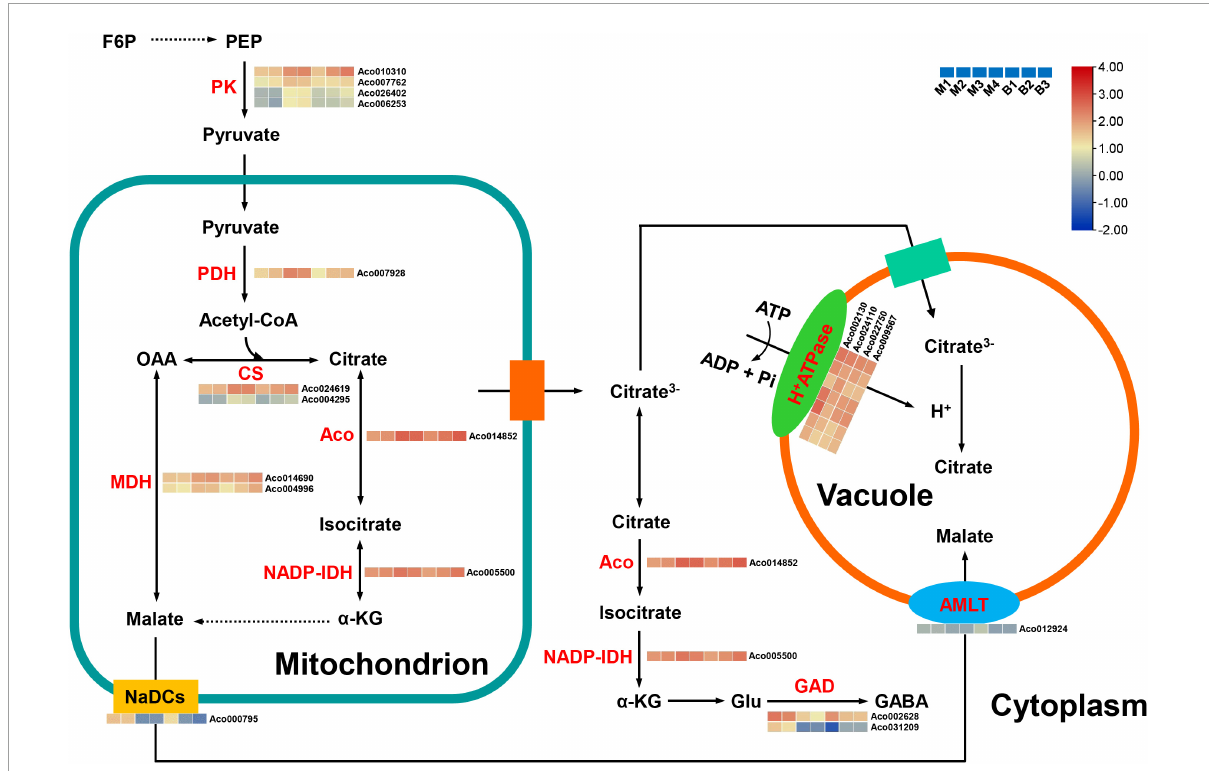
FIGURE8 Regulatory model and expression levels of the genes related to citric acid and malic acid metabolism and accumulation in pineapple fruits. From blue to red in the heatmap indicates the expression levels of the genes ranging from low to high in two pineapple cultivars throughout fruit development. M1, M2, M3, and M4 represented fruit flesh samples for M at 40, 80, 100, and 120 DAA, respectively, and B1, B2, and B3 represented fruit flesh samples for B at 40, 80, and 100 DAA, respectively. PK, pyruvate kinase; PDH, pyruvate dehydrogenase; CS, citrate synthase, ACO, aconitase; MDH, malate dehydrogenase; NADP-IDH, isocitrate dehydrogenase NADP; GAD, glutamate decarboxylase; ALMT, aluminum-activated malate transporter; NaDCs, sodium-dependent dicarboxylate transporter. PEP, phosphoenolpyruvate; a-KG, a-ketoglutarate; Glu, glutamate; GABA, γ -aminobutyric